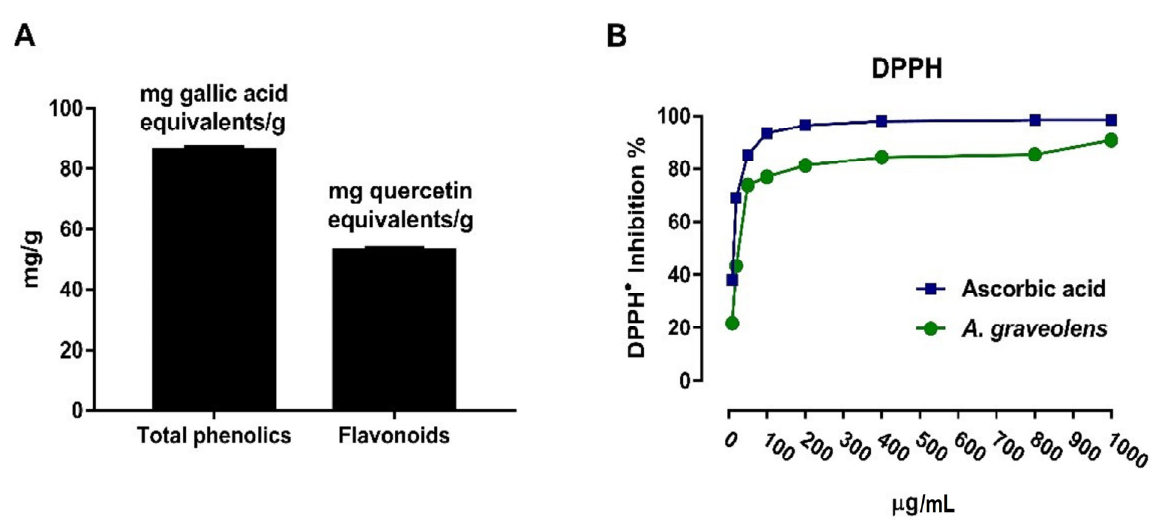
Figure 1. Total phenolics and flavonoids content ( A ) and 2,2-diphenyl-1-picrylhydrazyl (DPPH • )-scavenging activity A. graveolens ( B ). Data are the mean values of triplicate and expressed as mean ± standard deviation (SD).